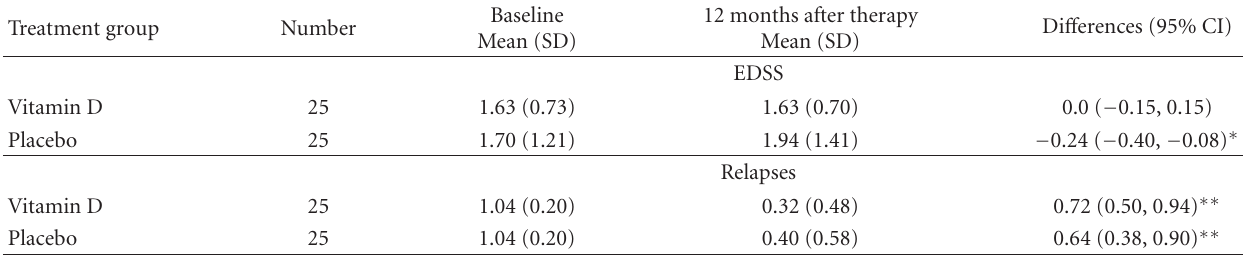
Table 2: Comparison of Expanded Disability Status Scale (EDSS) and relapses in 50 patients with relapsing-remitting multiple sclerosis before and 12 months after treatment with low-dose vitamin D and